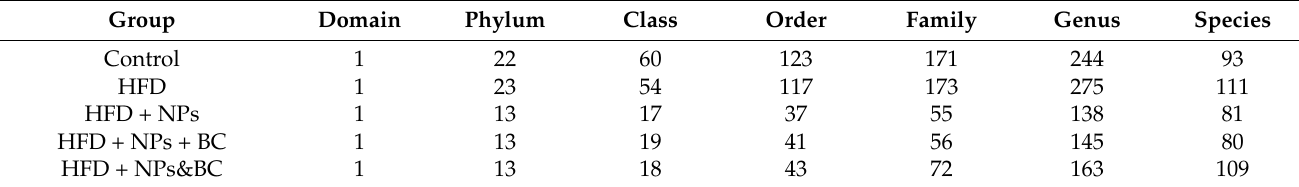
Table 2. Classification of ASVs in each group and the identification of taxonomics.